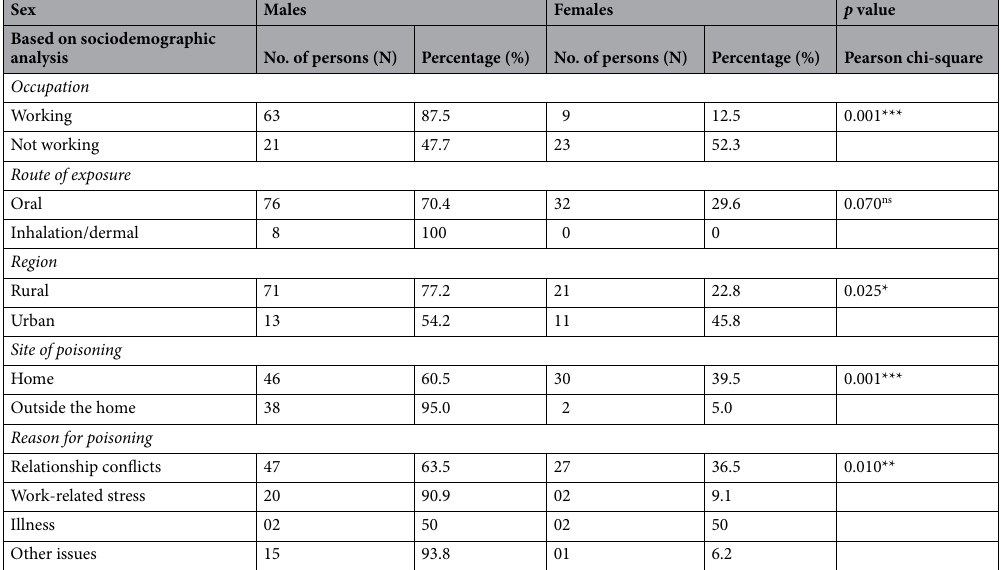
Table 2. Sociodemographic characteristics and details of OP-poisoned patients (N = 116) between the male and females. * p < 0.05, ** p < 0.01, and *** p < 0.001, and ns; nonsignificant, by using Pearson Chi-Square